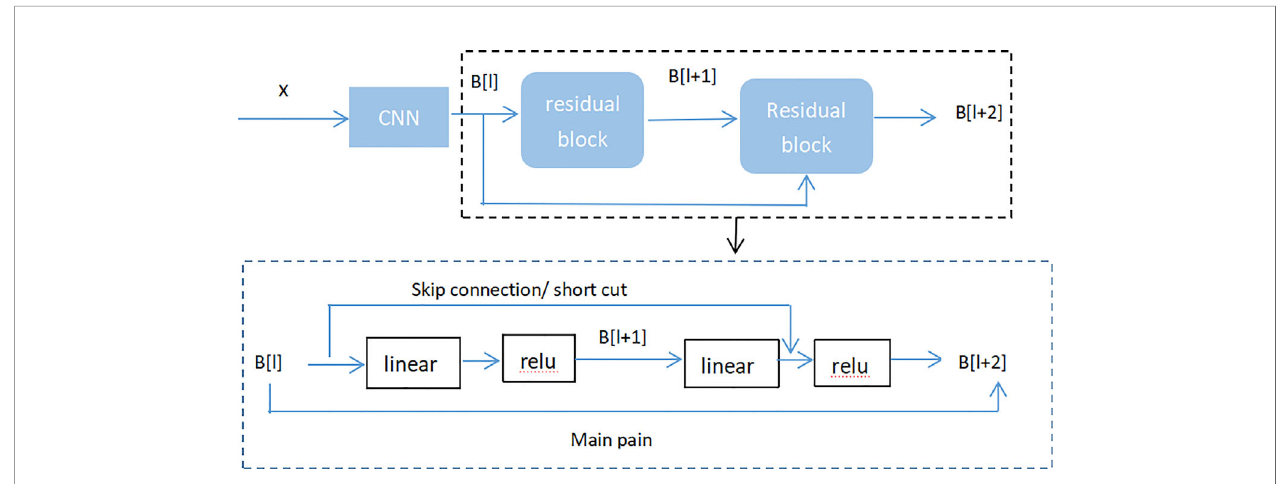
FIGURE 8 | Residual neural network fl ow chart, showed two-layer residual neural network. The activation is performed on the L layer to obtain B[l+